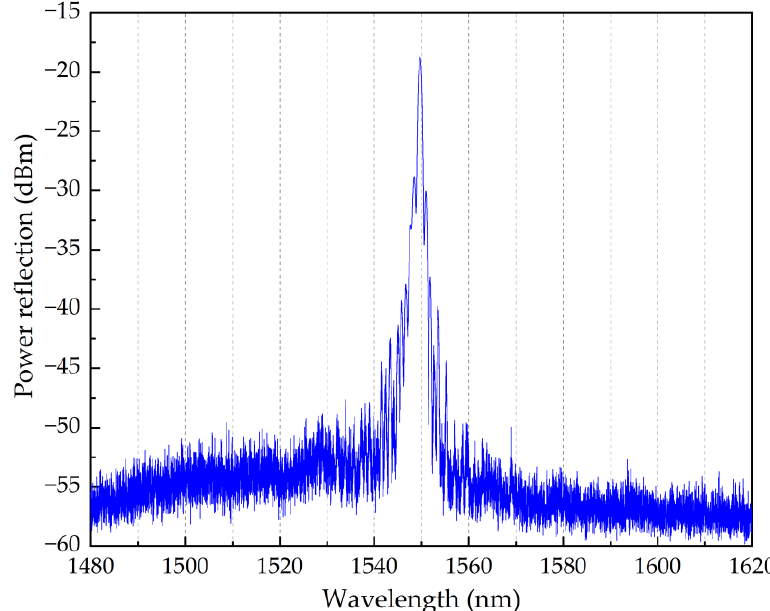
Figure 2. Reflection spectrum of a single POFBG